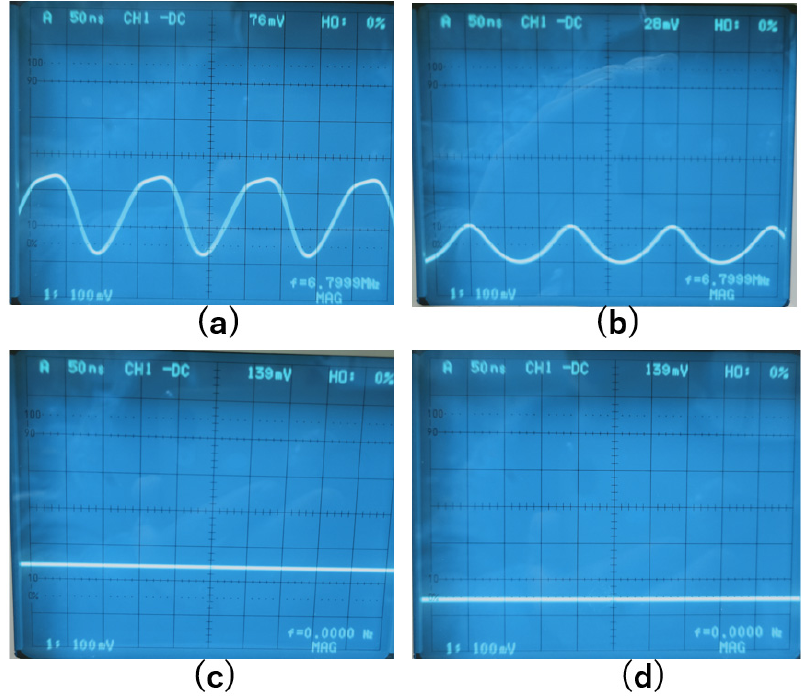
Figure 5. ( a ). Signal before the LPF without external magnetic field. ( b ). Signal before the LPF with 1 Gauss external magnetic field. ( c ). Signal after the LPF without external magnetic field. ( d ). Signal after the LPF with 1 Gauss external magnetic field.